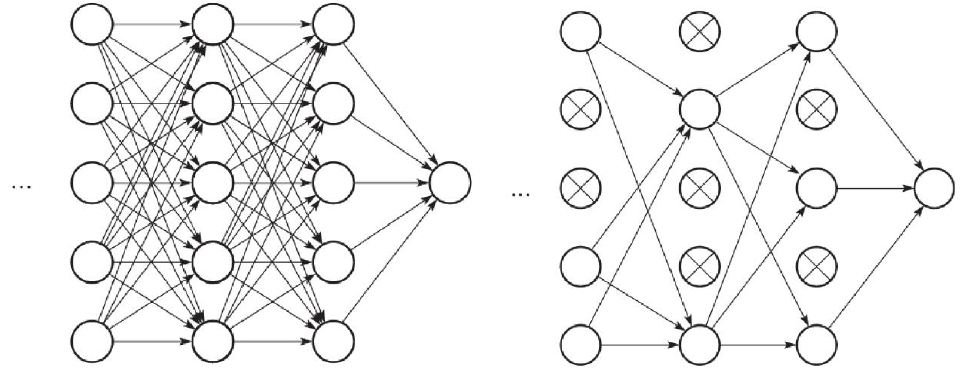
Figure 19. The Fully Connected Layer part of a neural network ( left ) and the Fully Connected Layer part after adding the Dropout layer ( right ).